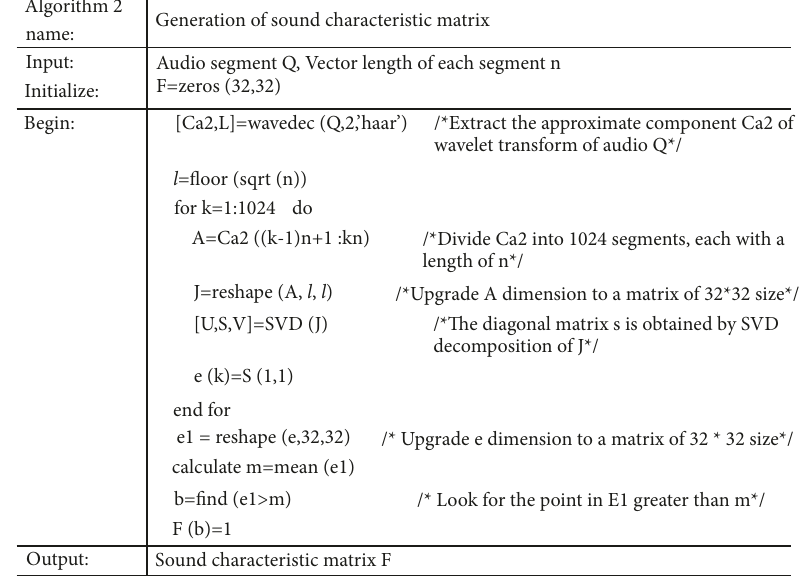
Figure 5: Pseudocode of sound feature matrix generation